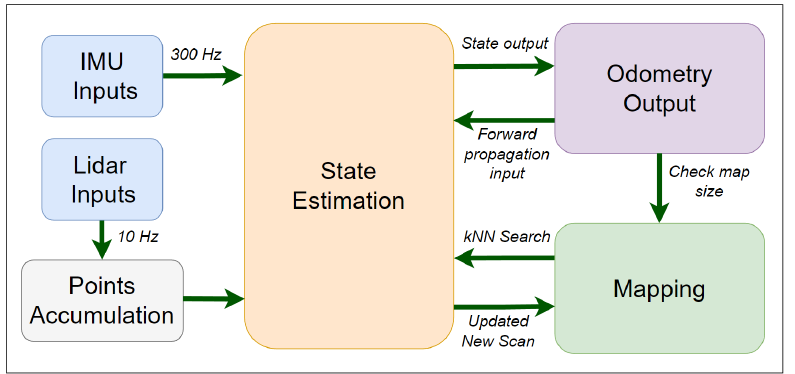
Figure 1. Simplified system overview of the original FAST-LIO2 SLAM